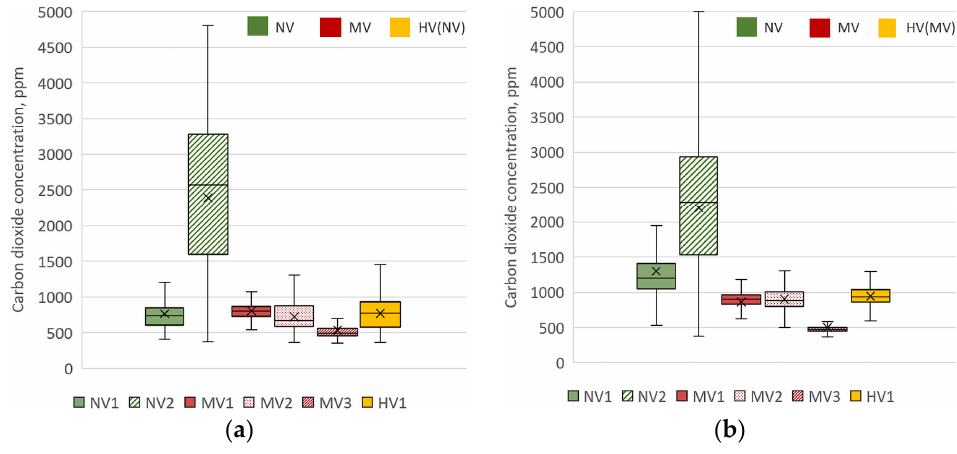
Figure 2. Bedroom carbon dioxide concentration, hours 11 pm–7 am: ( a ) summer–autumn; ( b ) winter. the rooms were maintained. Average values for NV1, MV1, MV2, HV1 ranged from 763 ppm to 805 ppm, and for MV3 533 ppm. Maintaining the level I category according to EN 16798-1 was achieved 62% (NV1), 40% (MV1), 65% (MV2), 93% (MV3) and 51% (HV1) of the time. The periods of exceeding the level of IV category were much shorter—2% (MV1) and 3% (NV1). In MV2 and HV1, the period of exceeding class IV was <0.3% of the time, and in MV3, no exceeding was recorded. In the cold season, in mechanically ventilated buildings,